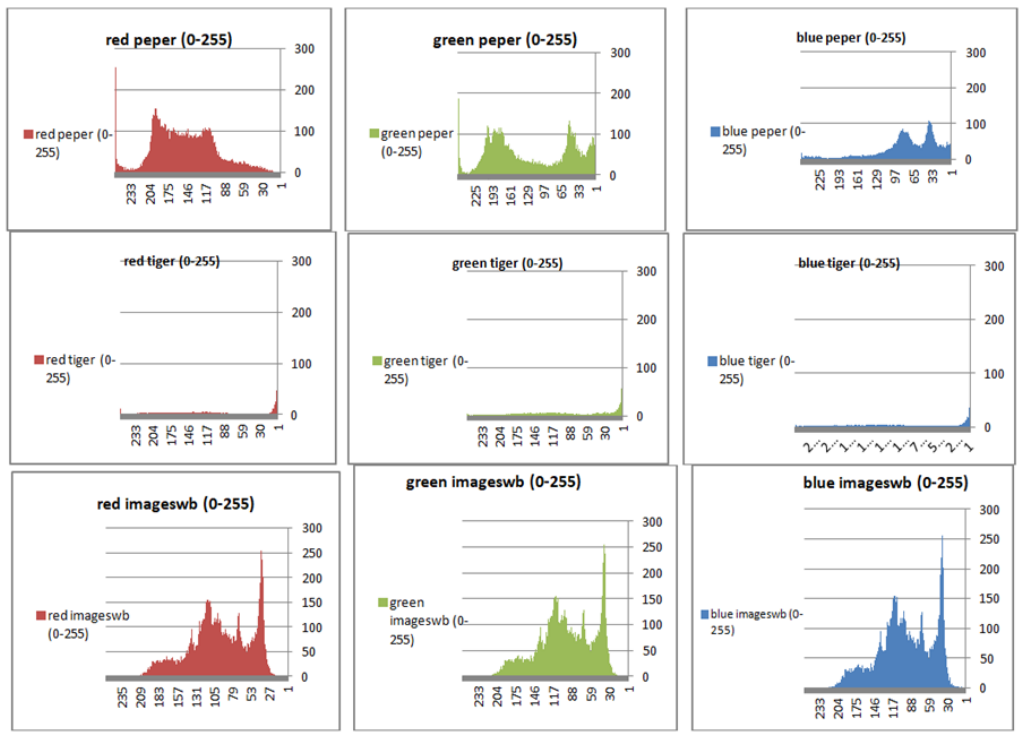
Figure 6. Histograms (red, green, and blue) for the original images.